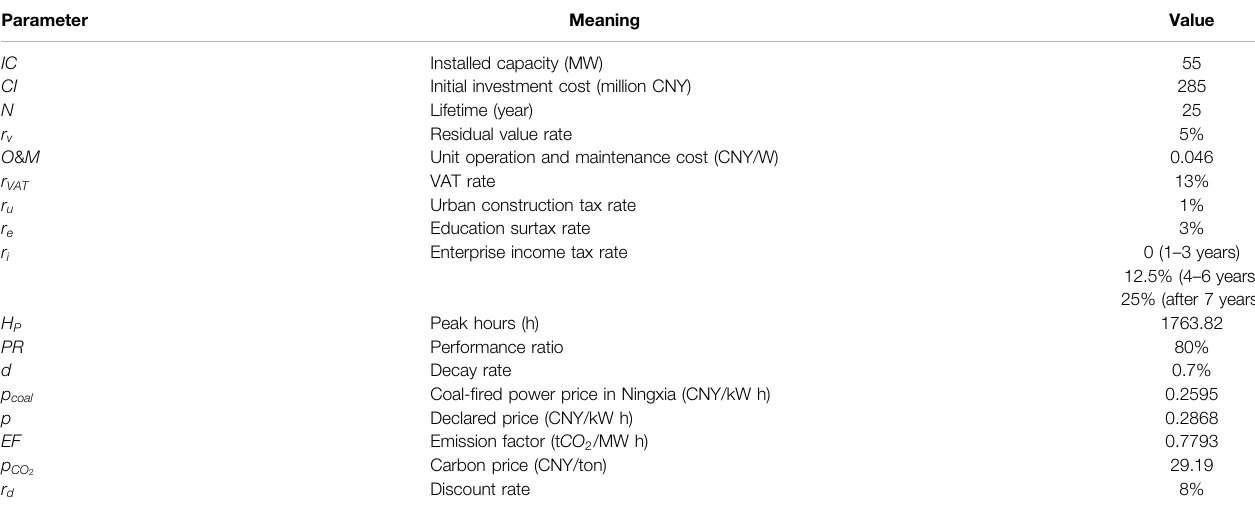
TABLE 1 | Relevant parameters of the Pingluo project.